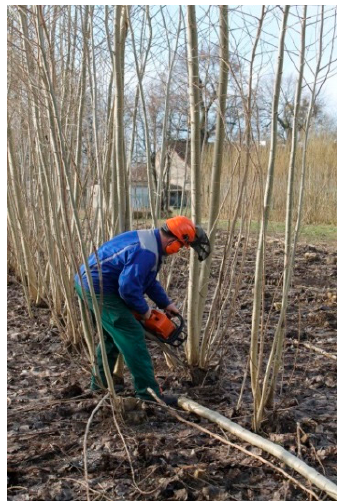
Figure 1. Manual harvest with a chainsaw.